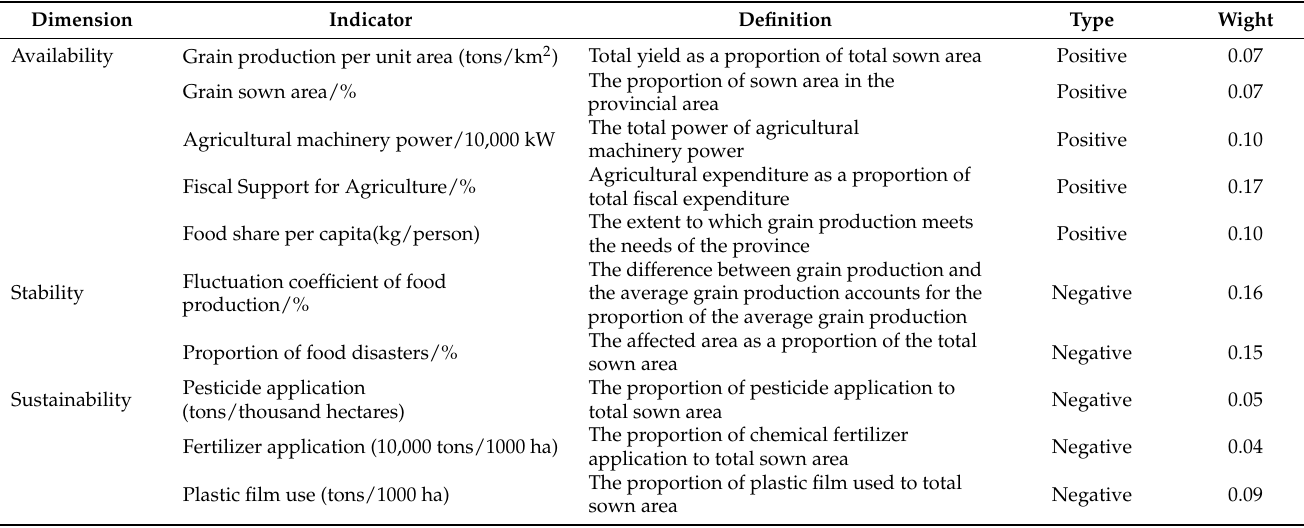
Table 2. Food security evaluation index system.